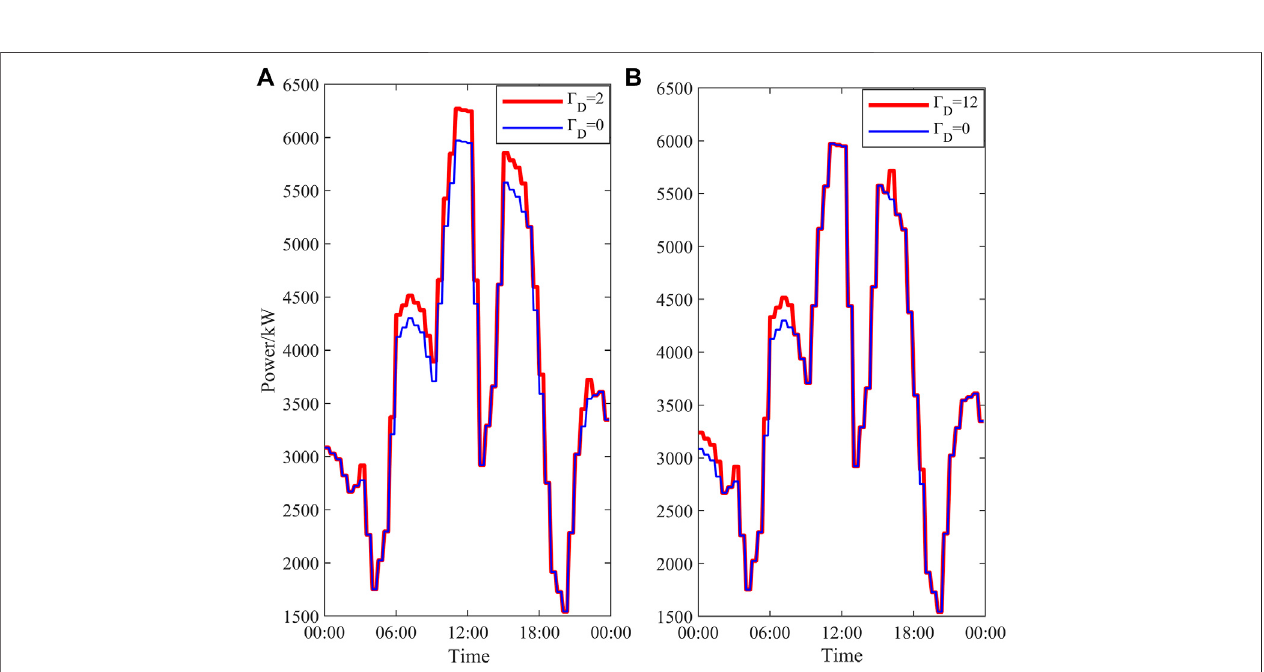
FIGURE 12 | Comparison of robust point of Γ _D = 2 (A) Rolling RO (B) Day-ahead RO.